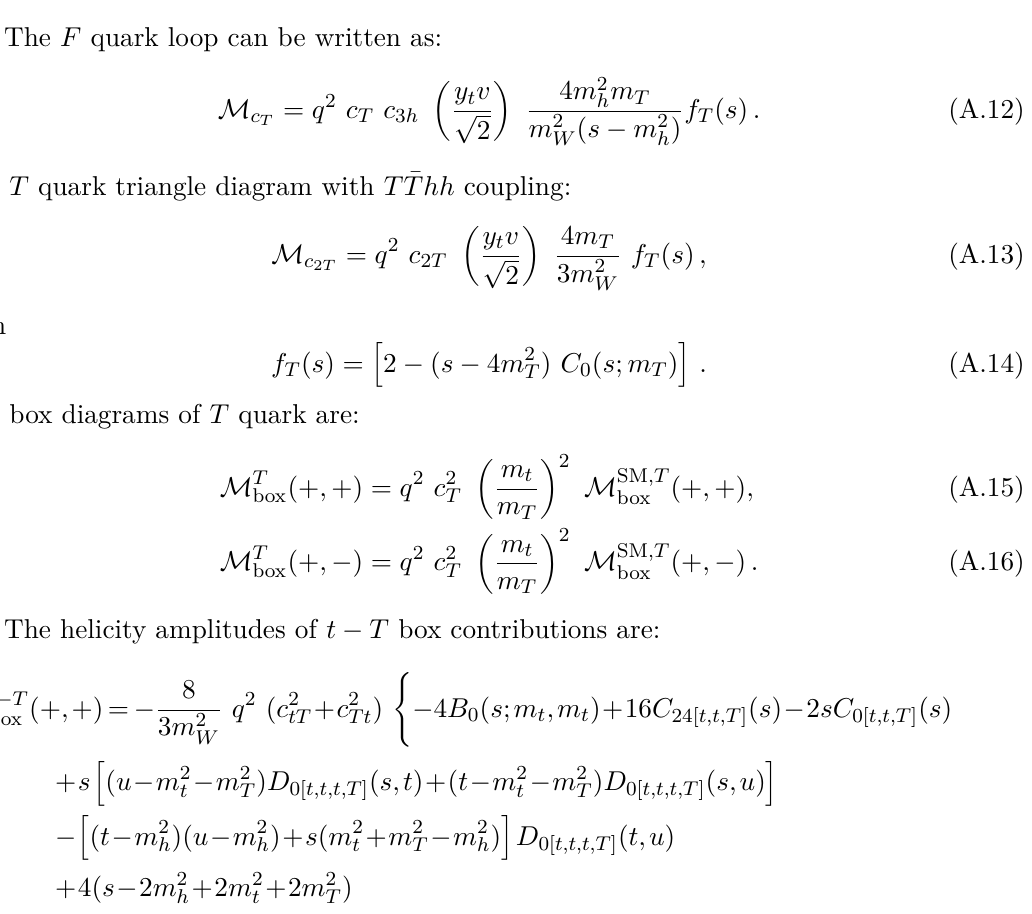
Figure 15 . Cross-sections for the individual contributions as given in tables 1 and 3 for γγ → hh same photon helicities (left panel) and e + e − → hh (right panel) in the presence of heavy scalar (as given in section